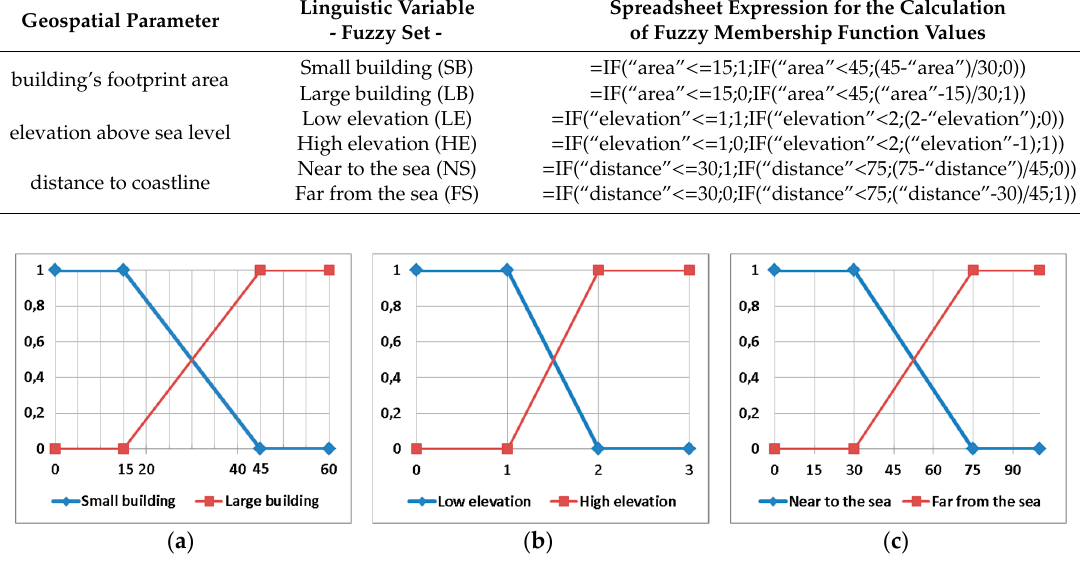
Figure 5. Graphs showing the fuzzy membership functions of key geospatial parameters: ( a ) small and large buildings for the building’s footprint area; ( b ) low and high elevations for elevation above the sea level; ( c ) near and far from the sea for distance to